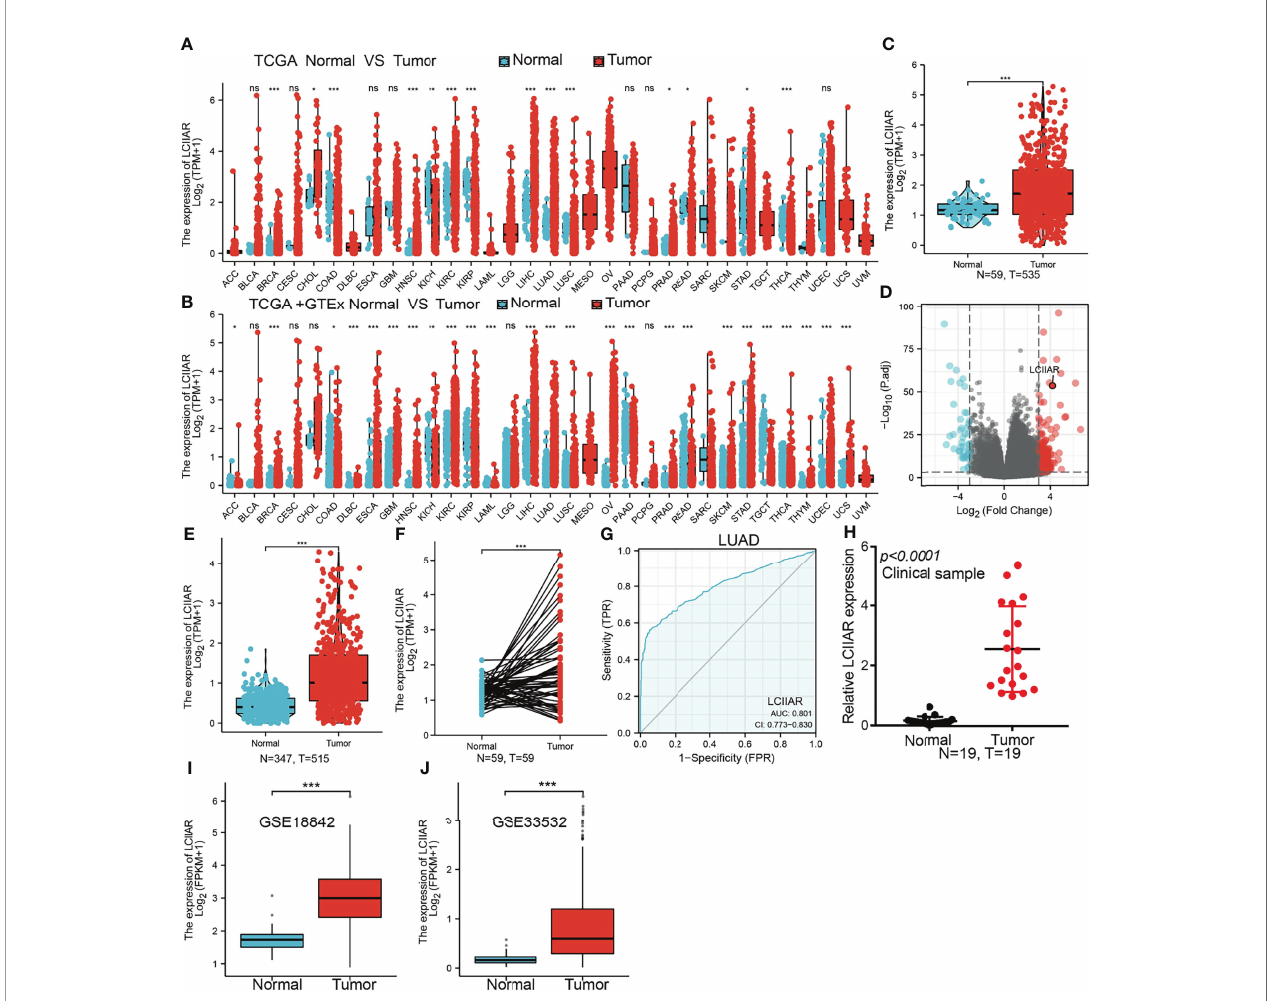
FIGURE 1 | LCIIAR was highly expressed in LUAD. (A-F) LCIIAR expression in LUAD and LUSC was examined by TCGA/GTEX databases (G) ROC curve analysis of the diagnostic value of LCIIAR in LUAD (H) LCIIAR expression in lung cancer tissues was examined by qPCR assay. (I, J) LCIIAR expression in lung cancer was examined by GEO dataset, NS: p>0.05, *p < 0.05, **p < 0.01, ***p <